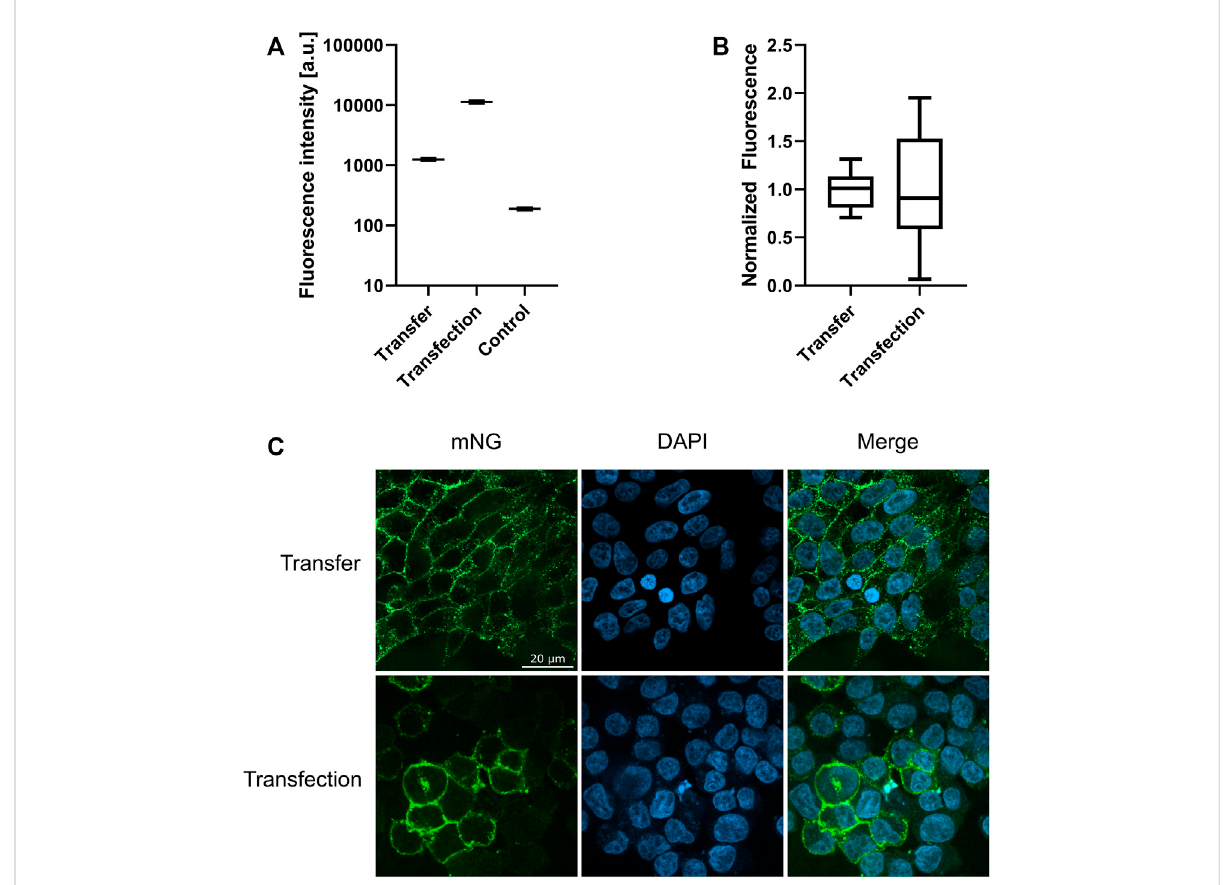
FIGURE 8 Membrane localization of transferred and transfected ETB-mNG. 0.5 µM ETB-mNG/NDs were incubated with HEK293T cells for 24 h. ETB- mNGwasfurthersynthesizedintransfectedHEK293Tcells.Fluorescencemicroscopyimagesof fi xedcellsweretakenafter24 hand fl uorescencein the cellular membrane was quanti fi ed. (A) Comparison of membrane fl uorescence in transfected and transferred cells. Mean ± SEM is shown. n = 20 cells. (B) Variation of mean-normalized membrane fl uorescence. (C) Representative imagesof HEK293Tcells with transferred ETB-mNG or with synthesized ETB-mNG after